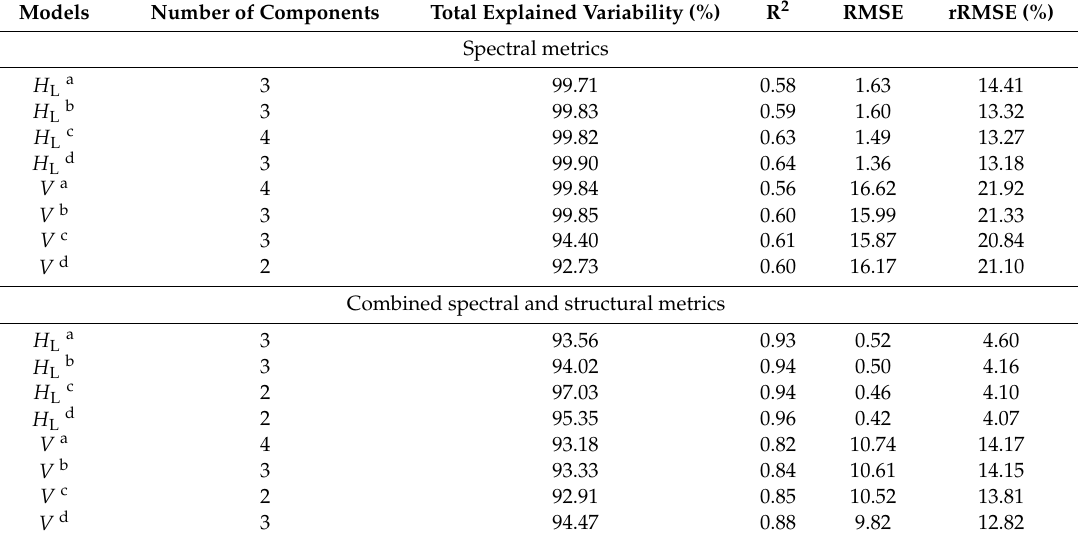
Table 6. Summary of the forest structural attributes prediction models with spectral and structural metrics derived from UAS RGB imageries and the DAP point cloud. The best models based on the standard error of the cross-validation residuals are displayed with the number of components, total explained variability (%), cross-validated coefficient of determination (R 2 ), cross-validated Root-Mean-squared-Error (RMSE), and relative RMSE (rRMSE). Models